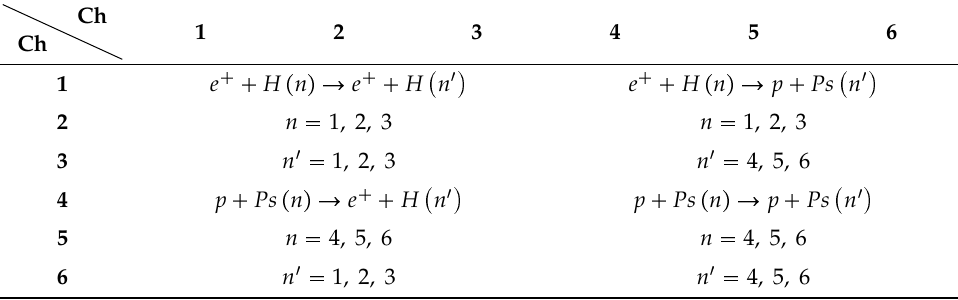
Table 5. Partition of the